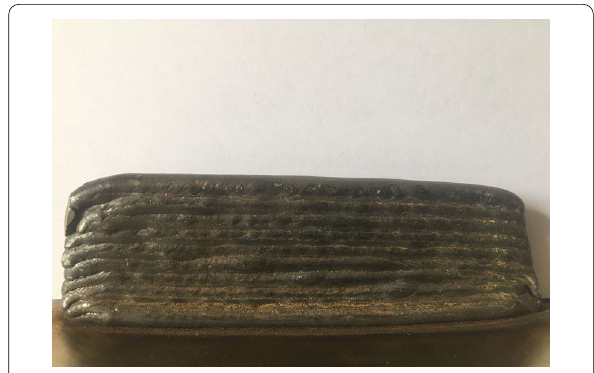
Figure 20 Single-walled component deposited using proposed self-adaptive control system